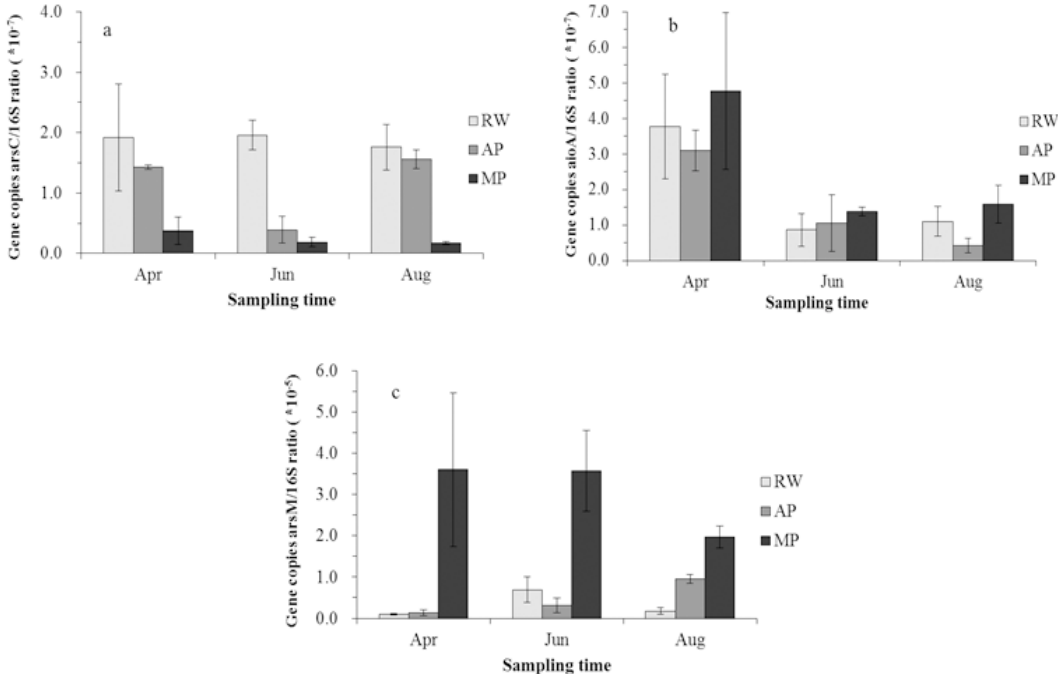
Figure 2. The abundance of As metabolism genes ( a : arsC gene; b : aioA gene; c : arsM gene) in different samples of raw wastewater (RW), acidogenic phase (AP), and methanogenic phase (MP) in different months.